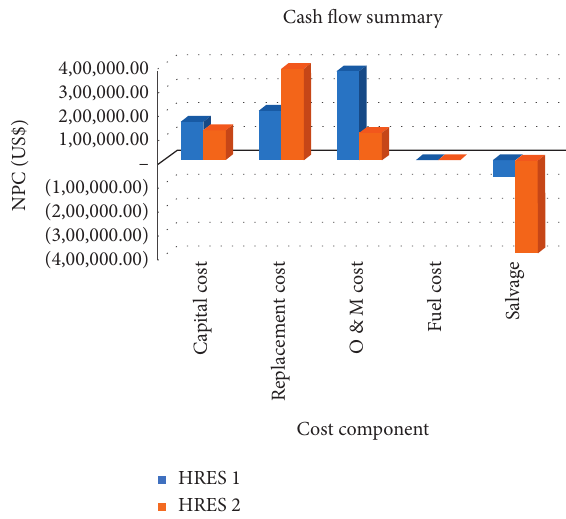
Figure 7: HRES scenario lifetime cost